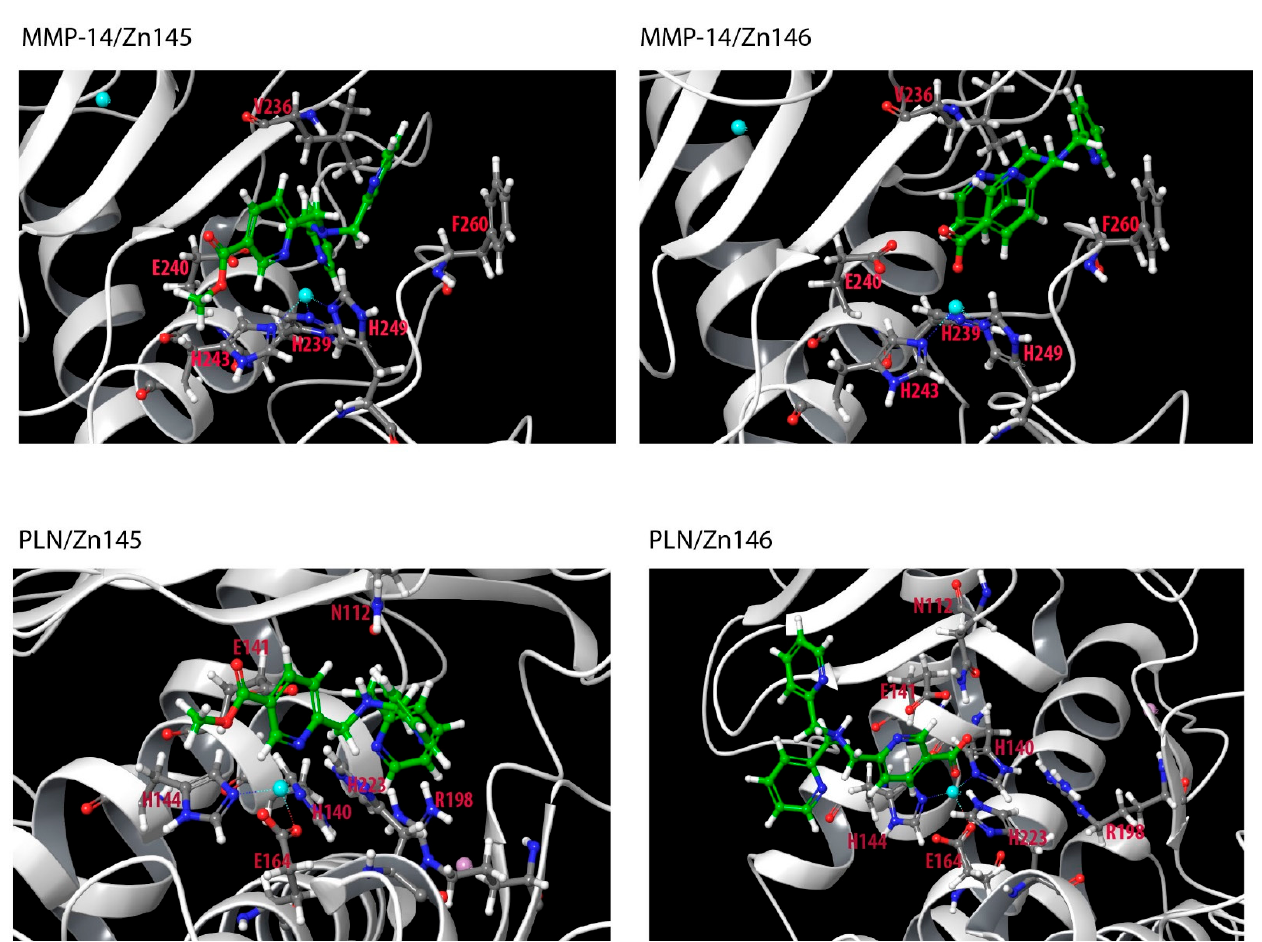
Figure 6. Zn145 and Zn146 docked into the catalytic site of MMP-14 and PLN. Some of the most